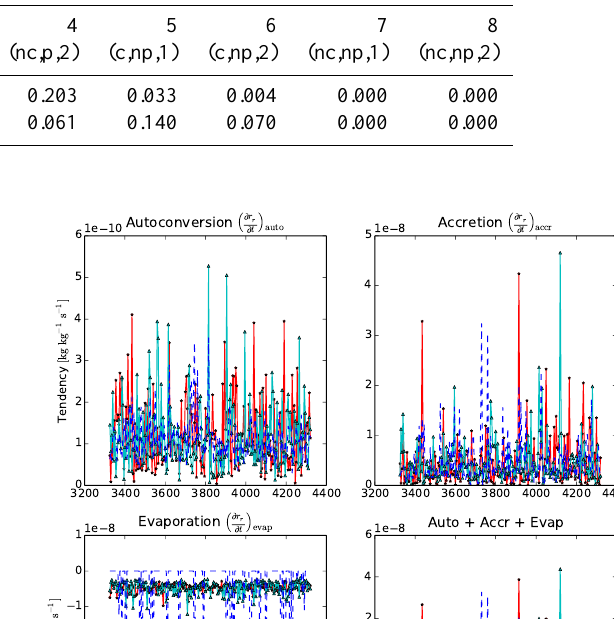
Table 3. Estimated optimal sampling fractions ( γ j ) for each importance category, averaged over the entire simulation, for the RICO and DYCOMS-II RF02 cases. These estimates were obtained by using SILHS to estimate the right-hand side of Eq. (21) for each category. Here “c” denotes “in-cloud”, “nc” denotes “out of cloud”, “p” denotes “in-precipitation”, “np” denotes “out of precipitation”, “1” denotes “in mixture component 1”, and “2” denotes “in mixture component 2”.